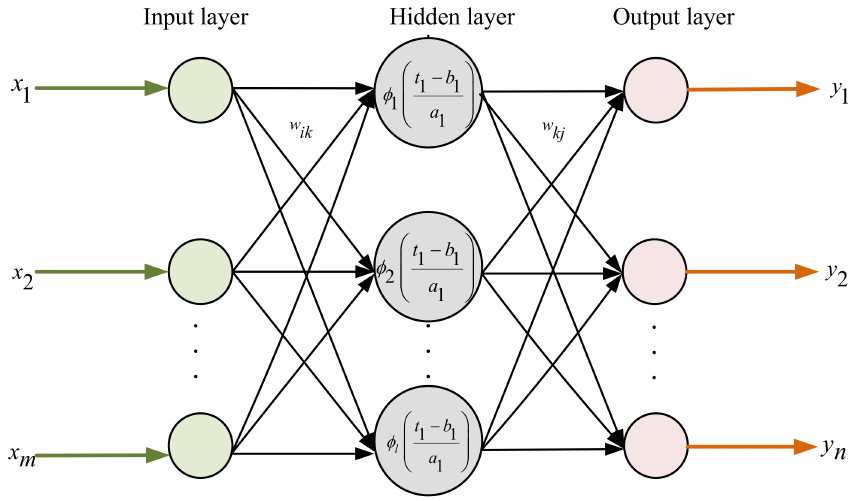
Figure 1. Basic structure of the WNN